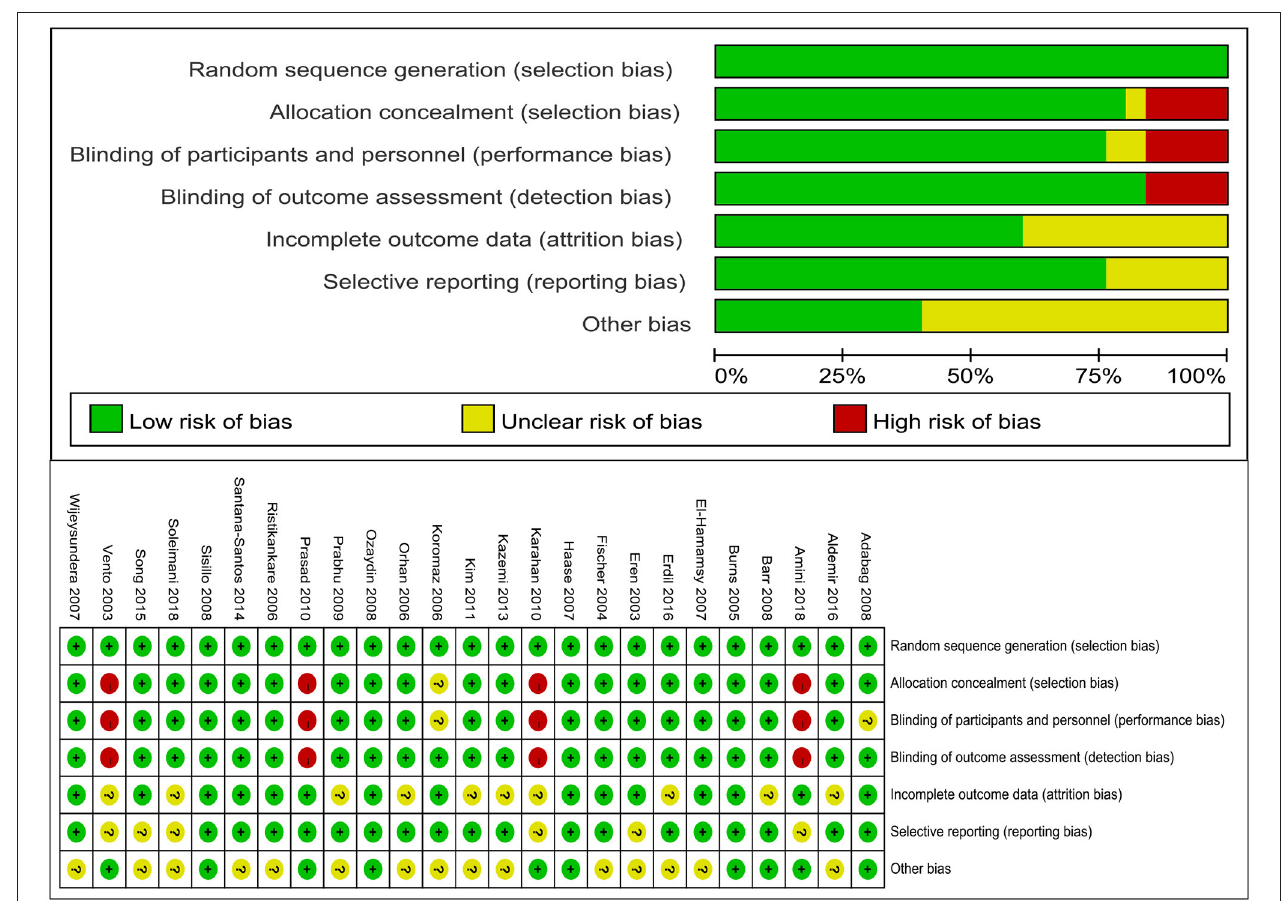
FIGURE 2 | Risk of bias assessment. “ + ” indicates low risk of bias, “ − ” indicates high risk of bias, “?” indicates unclear risk of bias.